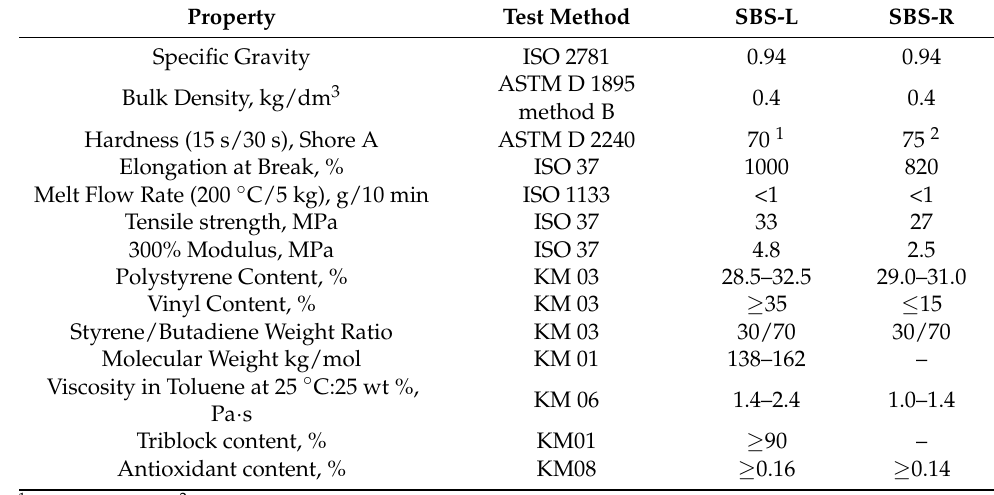
Table 1. Properties of linear copolymer styrene–butadiene–styrene (SBS)-linear (L) (D1192) and radial